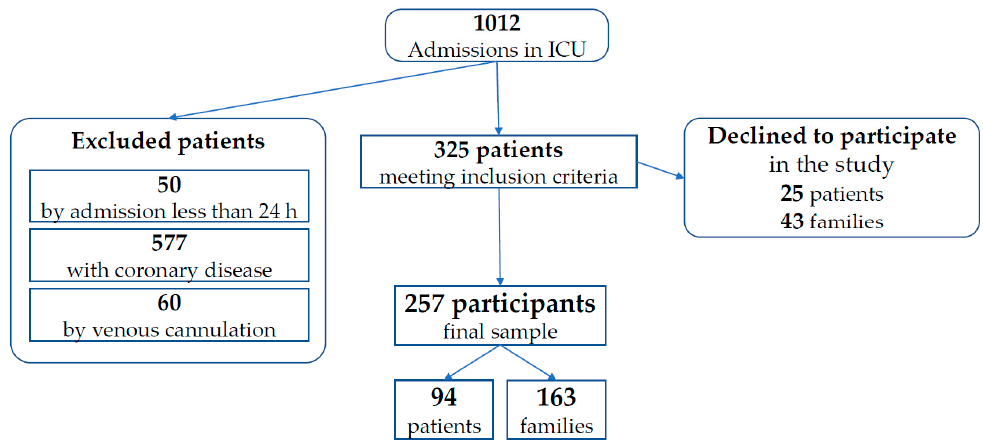
Figure 1. Flowchart of the participants’ selection process.